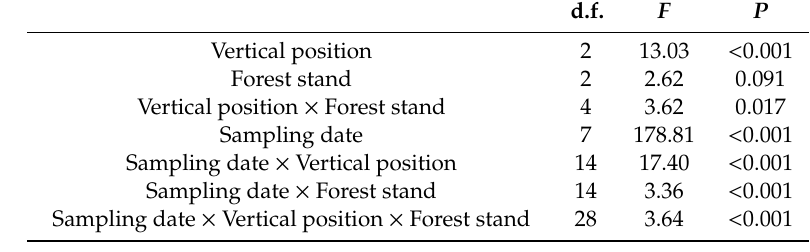
Table 2. Effects of the vertical position, forest stand, sampling date and their interactions on individual components of ecosystem respiration (ER) by repeated measures ANOVA analysis.